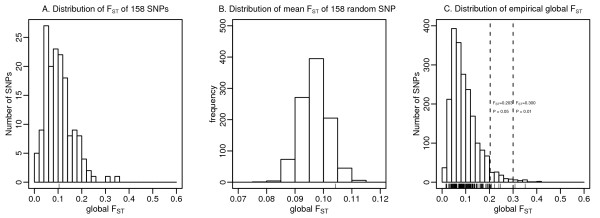
Distribution of FST. A. Distribution of FST of 158 SNPs associated with cardiovascular diseases and related intermediate traits. The vertical bar shows the mean of global FST of these 158 SNPs (FST = 0.1042). B. Distribution of empirical global mean FST of 158 autosomal SNPs randomly sampled from HGDP database 1000 times. The distribution of minor allele frequency of the randomly selected 158 SNPs was matched to the observed 158 SNPs. The vertical bar shows the mean of global FST of 158 SNPs associated with cardiovascular diseases and related intermediate traits (FST = 0.1042). C. Distribution of empirical global FST of 2,036 markers assumed to be neutral, genotyped in 938 unrelated individuals form HGDP. Two vertical lines indicate 95% and 99% percentile of the global FST distribution. The vertical bars show the values of global FST value of 158 susceptibility SNPs in the present study.